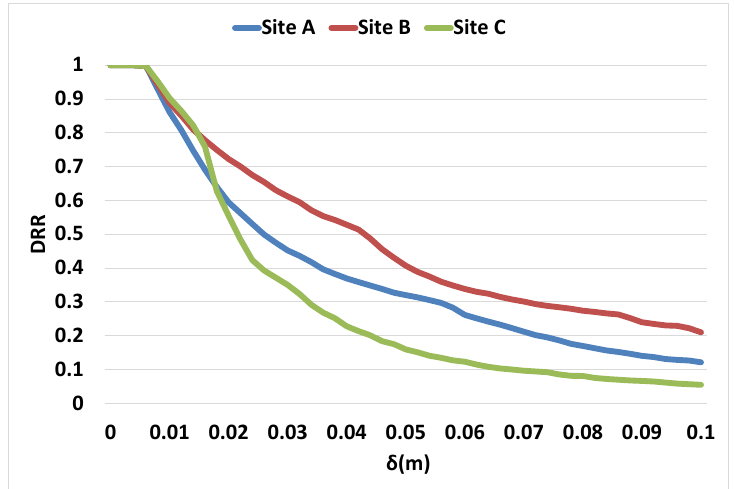
Figure 23. Data reduction ratio with change in δ